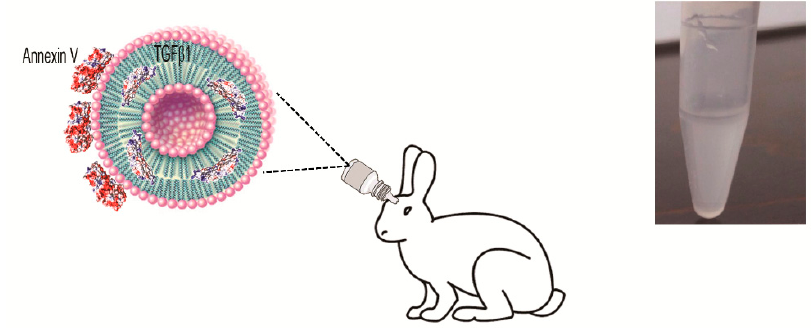
Figure 2. Description of topical liposomal suspension loaded with TGF- β 1.